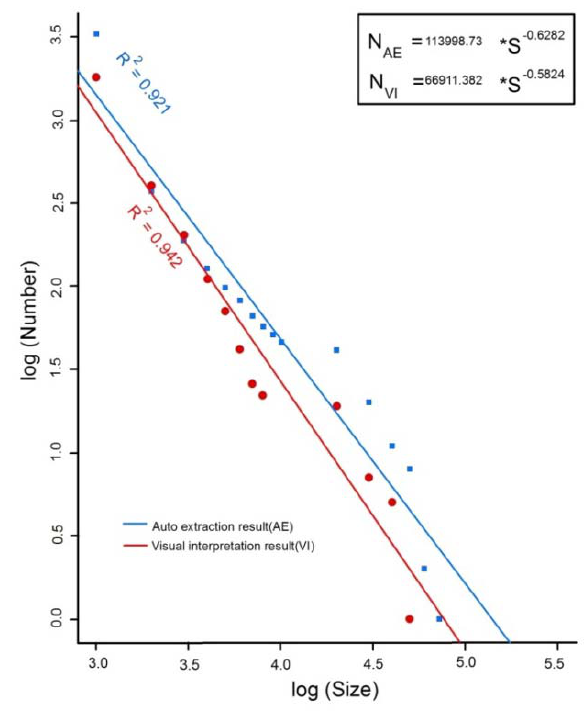
Figure 13. Distribution plot of automatic extraction and visual interpretation of recent landslides within the selected area. In the graphs, the x-axis shows the log of size, the y-axis shows the log of the number of